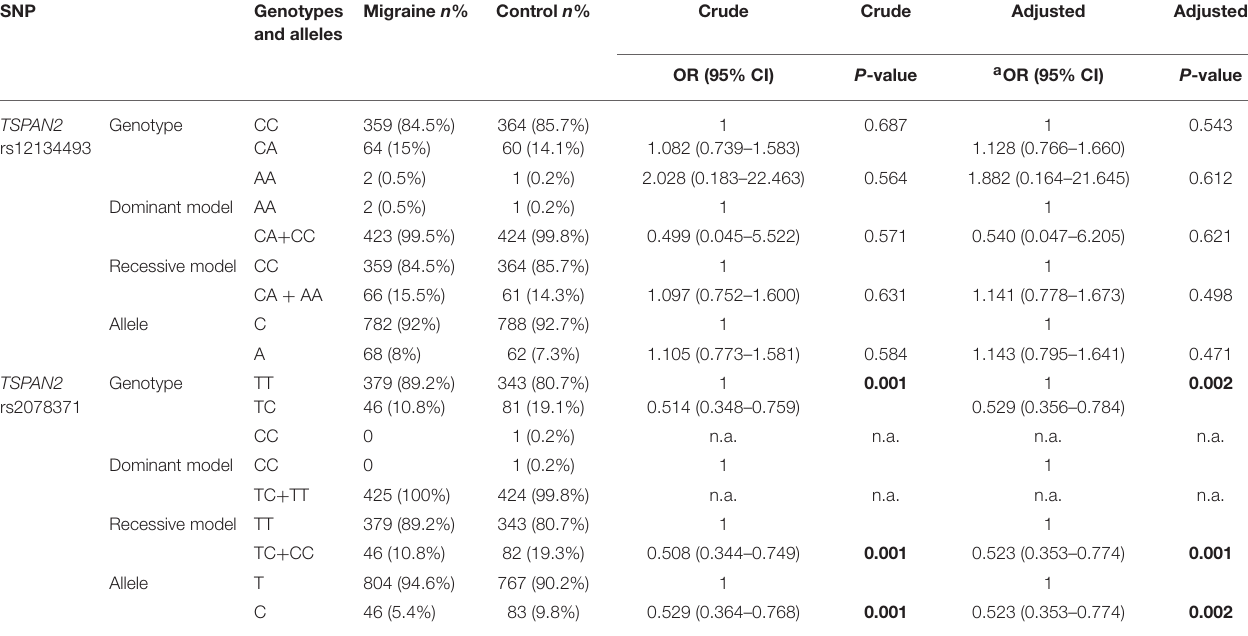
TABLE 2 | Genotype and allelic frequencies of the TSPAN2 SNPs in patients and controls.